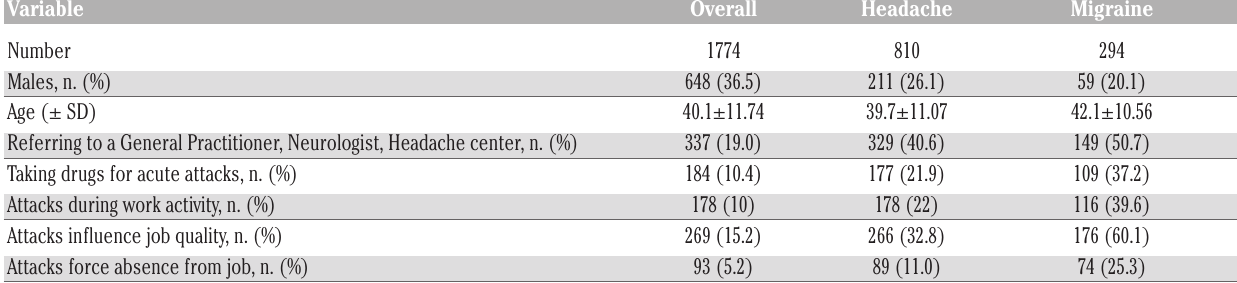
Table 3. Epidemiological